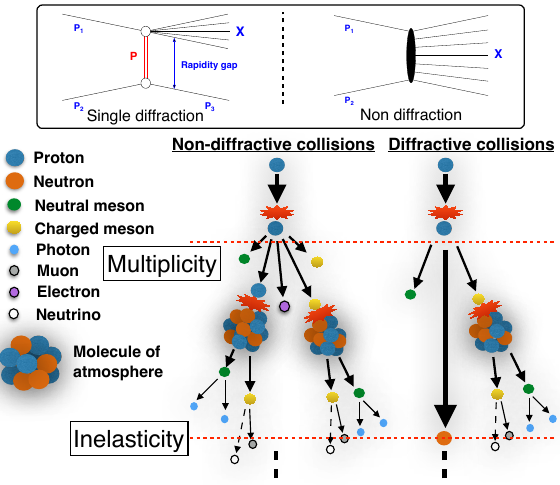
Figure 1. The Feynman diagrams of Single Di ff raction (SD, pp pX ) and Non-Di ff raction (ND, pp X ) in the box. Image → → of air-shower development in the atmosphere (bottom pad). The interaction between a primary cosmic-ray and the atmosphere will have a significantly di ff erent air-shower profile when the col- lision type is di ff erent: di ff raction or non-di ff raction. It will di- rectly impact on the parameters of multiplicity and inelasticity which will a ff ect the determination of X max